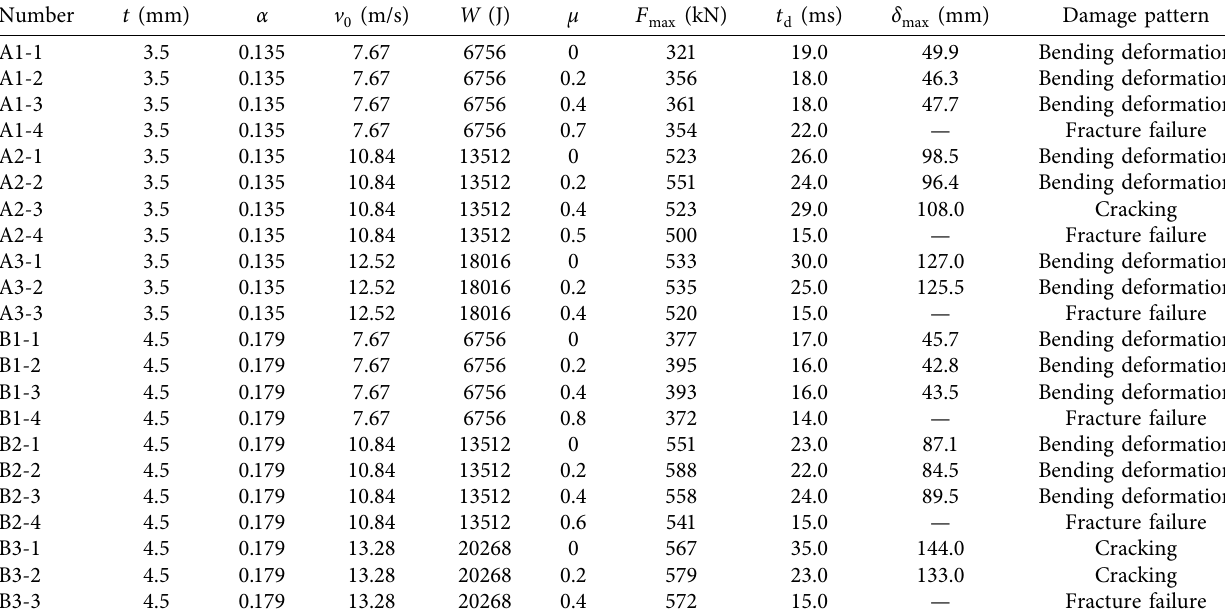
Table 3: Impact conditions and simulation results of CFST